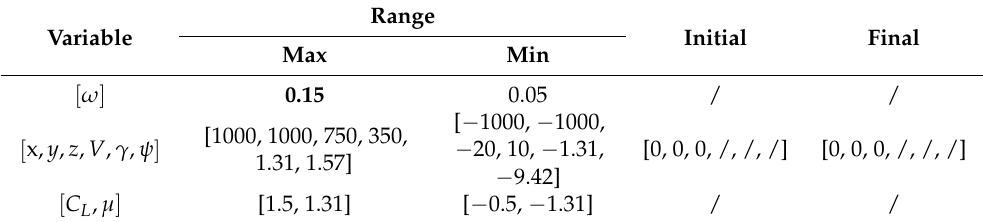
Table 3. The information of the design, state, and control variable of test 4.2. Range Variable